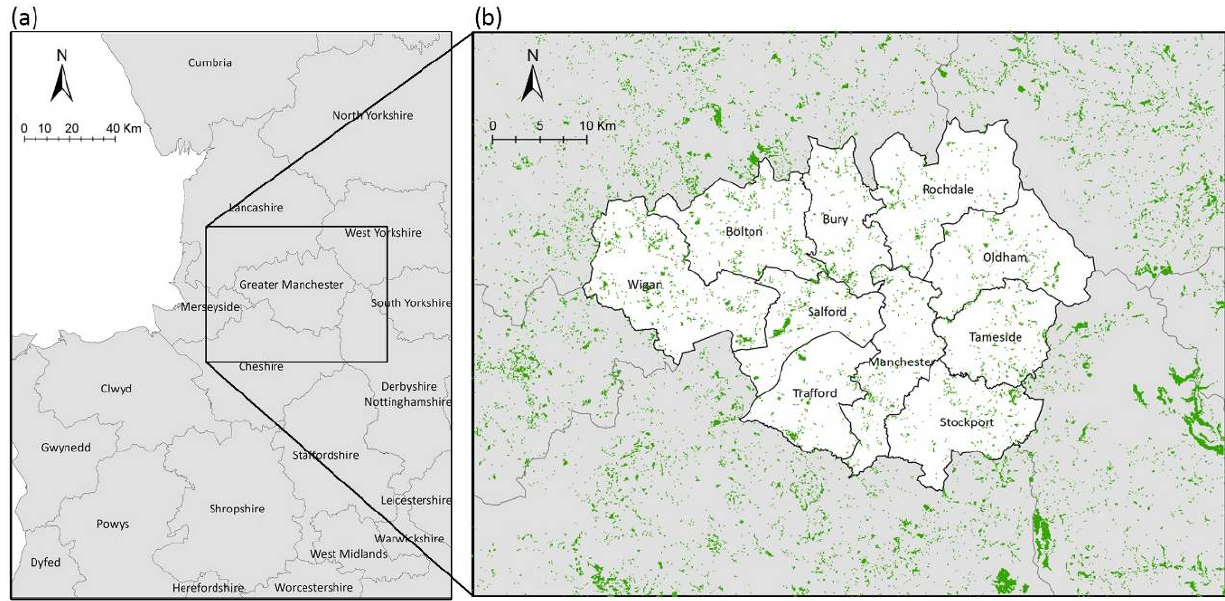
Figure 1. The study area: (a) the location of the study area; (b) woodlands in the study area. the bias that would result from selecting a study area with merely administrative delimitations, the land-cover data are extended into the peripheral regions surround-